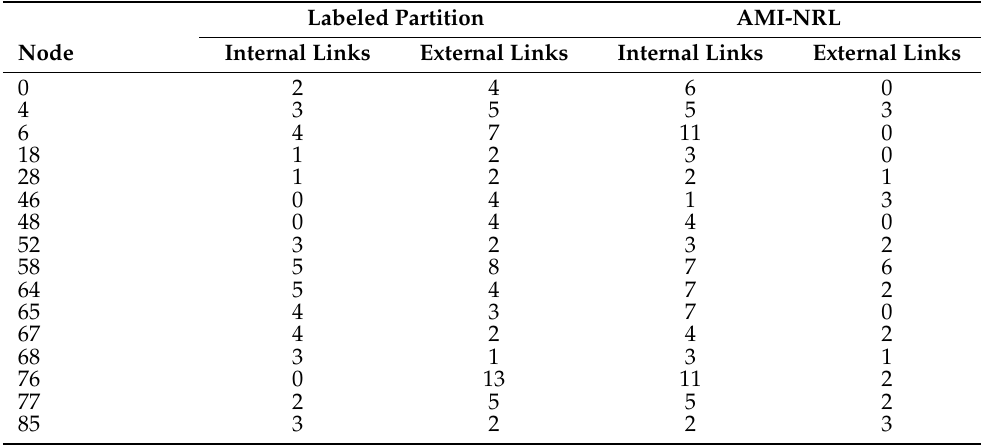
Table 5. Link analysis of the result and the labeled community partition on Polbooks. Labeled Partition AMI-NRL Node Internal Links External Links Internal Links External Links 0 2